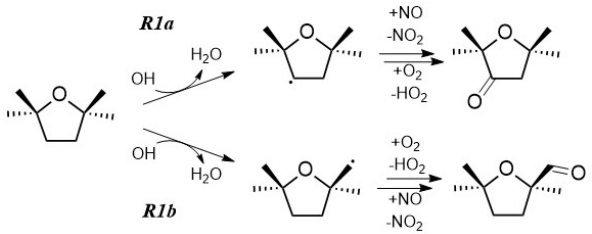
Figure 1. The chemical structure of TMO and the two possible breakdown routes following Reaction (R1) with OH. The differ- ing reactivities of the ketone (Reaction R1a) and aldehyde (Reac- tion R1b) products with respect to reaction with OH and to photoly- sis will control subsequent breakdown chemistry and ultimately the impact of TMO on air quality metrics such as O 3 production. Note that reaction of TMO with Cl (R2) would proceed via two equiva- lent